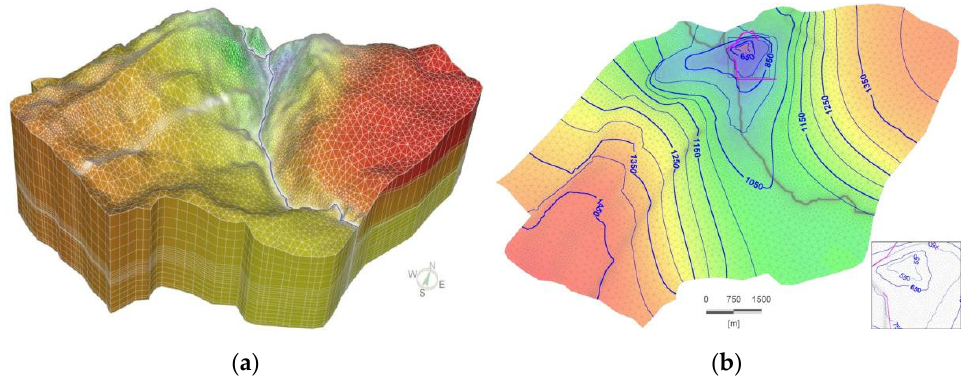
Figure 5. Mine curtain grouting model of a lead-zine mine, China: ( a ) Modflow model; ( b ) ground- water flow field after curtain grouting.